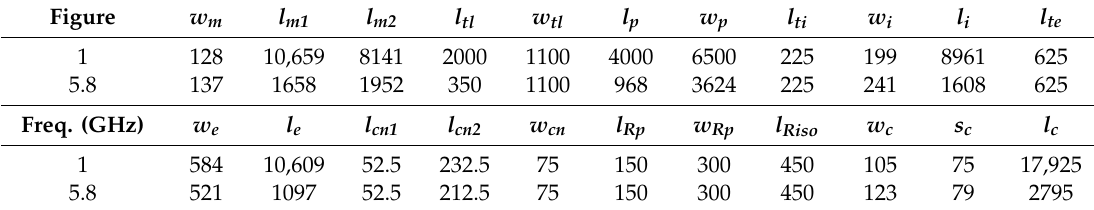
Figure 5. The layout of the synthesized power divider with definitions of physical geometries. Table 1. Dimensions for the power divider designed at 1 GHz and 5.8 GHz.